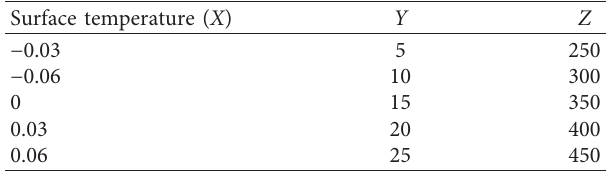
Table 1: Surface temperature.